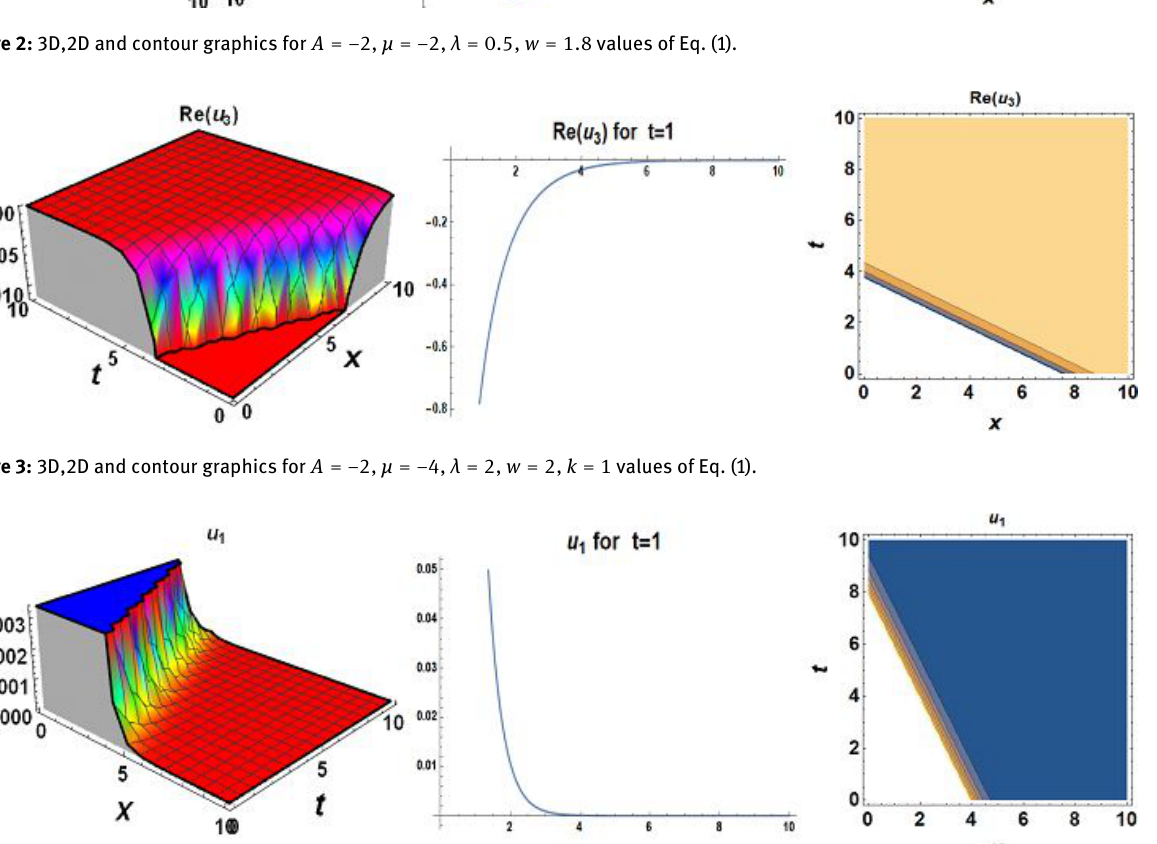
Figure 2: 3D,2D and contour graphics for A = −2, µ = −2, λ = 0.5, w = 1.8 values of Eq. (1).